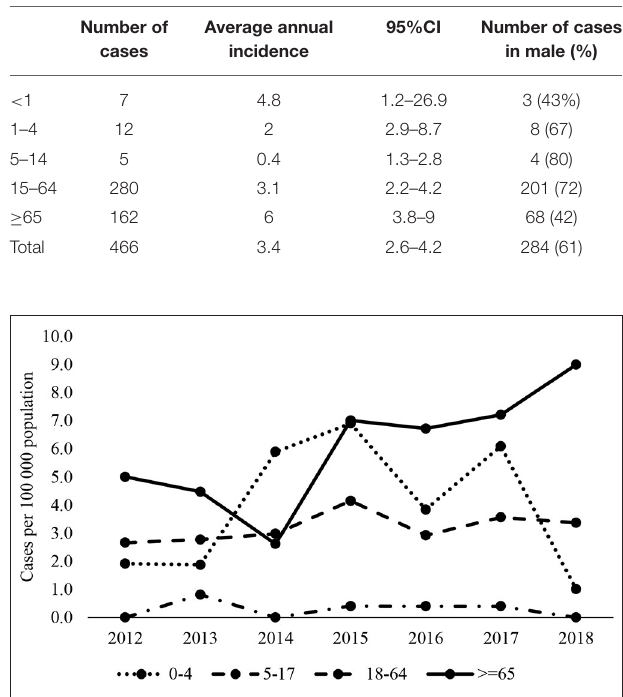
FIGURE 1 | Trends in IPD incidence, distributed by age groups,